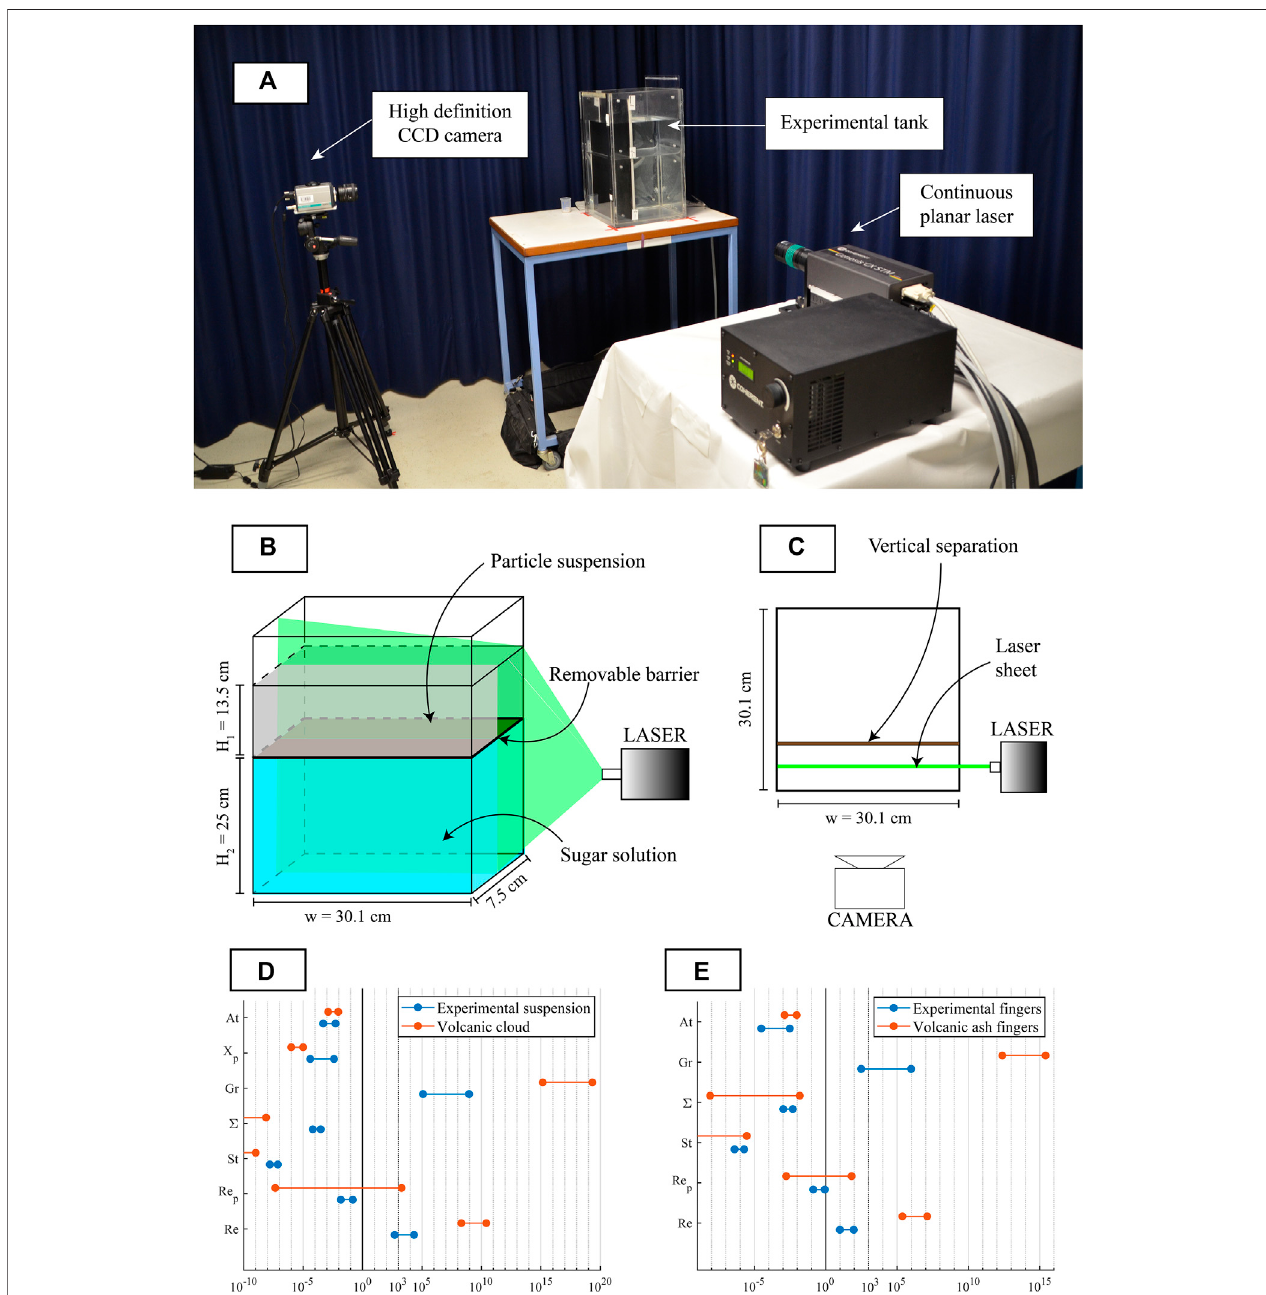
FIGURE 2 | (A) Experimental apparatus (B) Schematic of the tank con fi guration before barrier removal. The upper layer has a thickness H 1 that varies from 5 to 21 cm and is kept constant at 13.5 cm in type A experiments. In all experiments, the lower layer is a dense sugar solution with a thickness H 2 of 25 cm. The width of the tank w is 30.1 cm (C) Top view of the experimental con fi guration. The vertical separation and the laser plane are located 7.5 and 4.5 cm from the tank ’ s front wall, respectively. (D) Comparison between experimental and natural dimensionless numbers ( Re , Flow Reynolds number; Re p , Particle Reynold number; St , Stokes number; Σ , Sedimentation number; Gr , Grashof number; X p , Particle volume fraction; At , Atwood number) associated with ash clouds and (E) fi ngers. The vertical solid and dotted lines underline the values of 10 0 and 10 3 that are important for most dimensionless numbers.